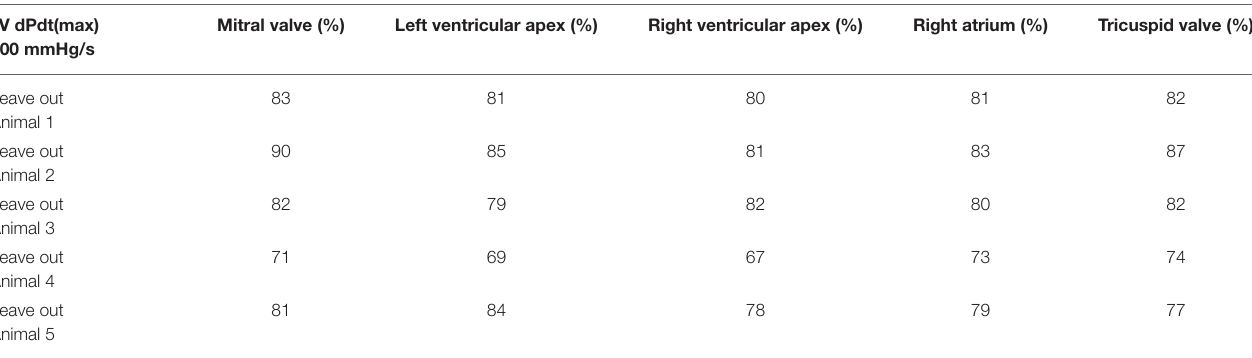
TABLE 3 | Accuracy optimization using holdout validation results generated by the “Leave one out”